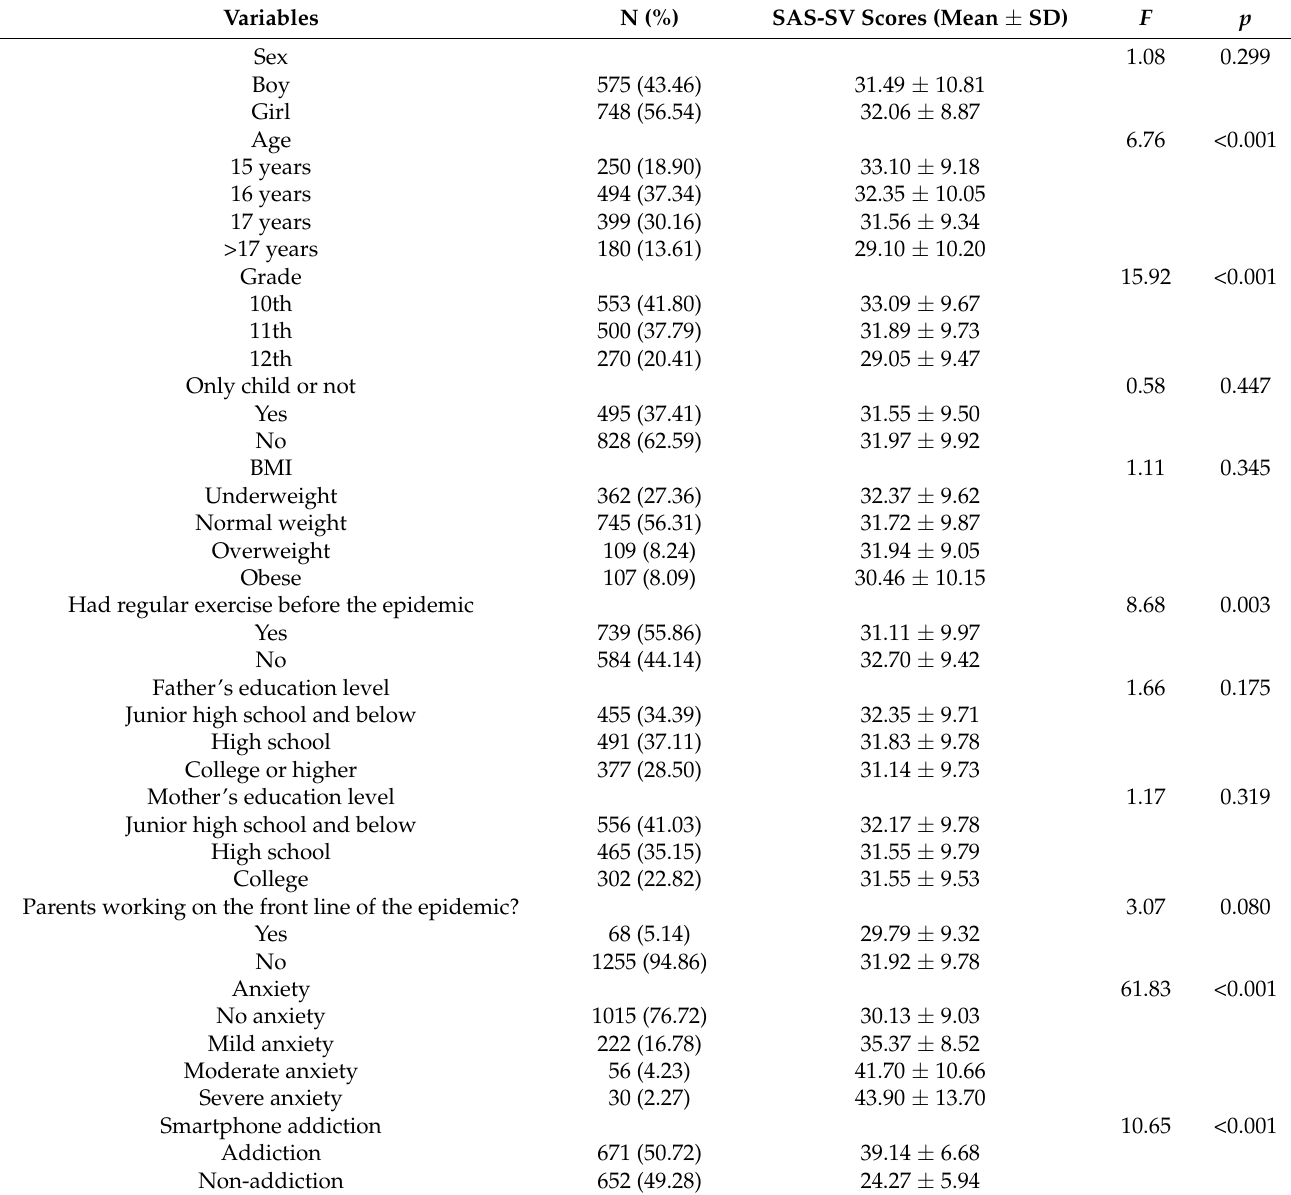
Table 1. Socio-demographic characteristics of participants during the